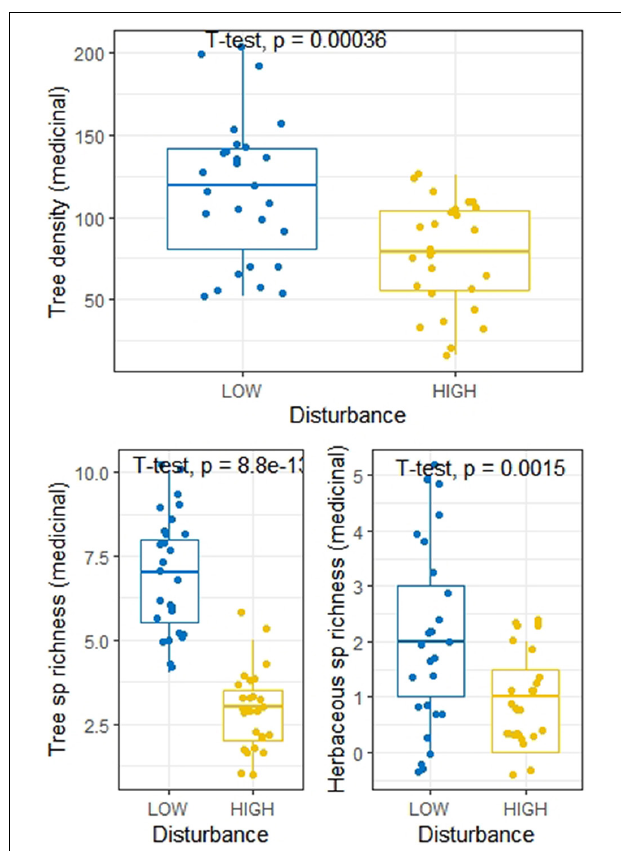
FIGURE 5 | Boxplot showing distribution of tree density, tree species richness, and herbaceous species richness of medicinal plants at low and high disturbed